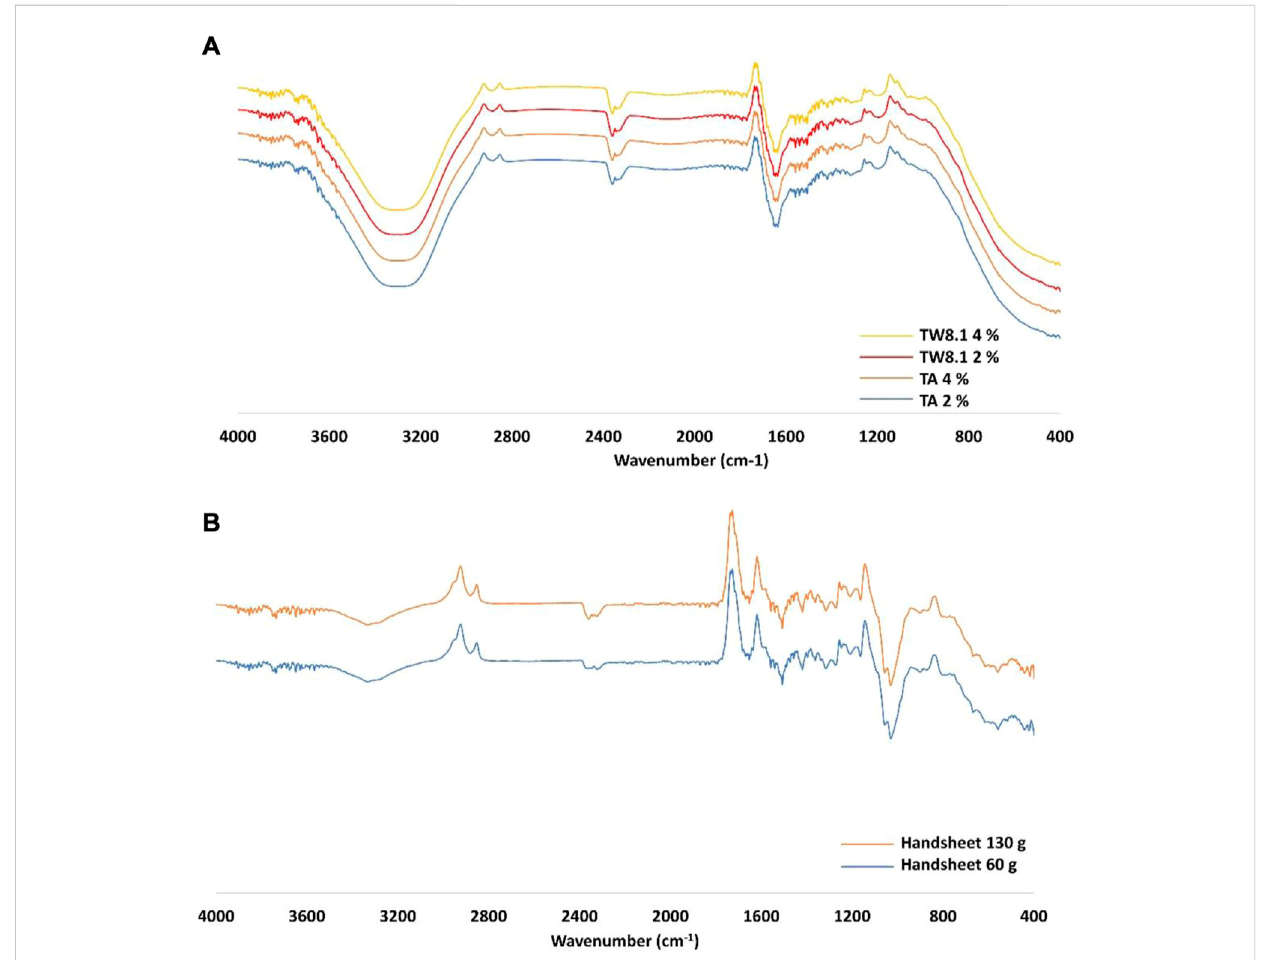
FTIR spectra comparison of (A) tannic acid (TA) and TW extract and (B) 60 g/m 2 and 130 g/m 2